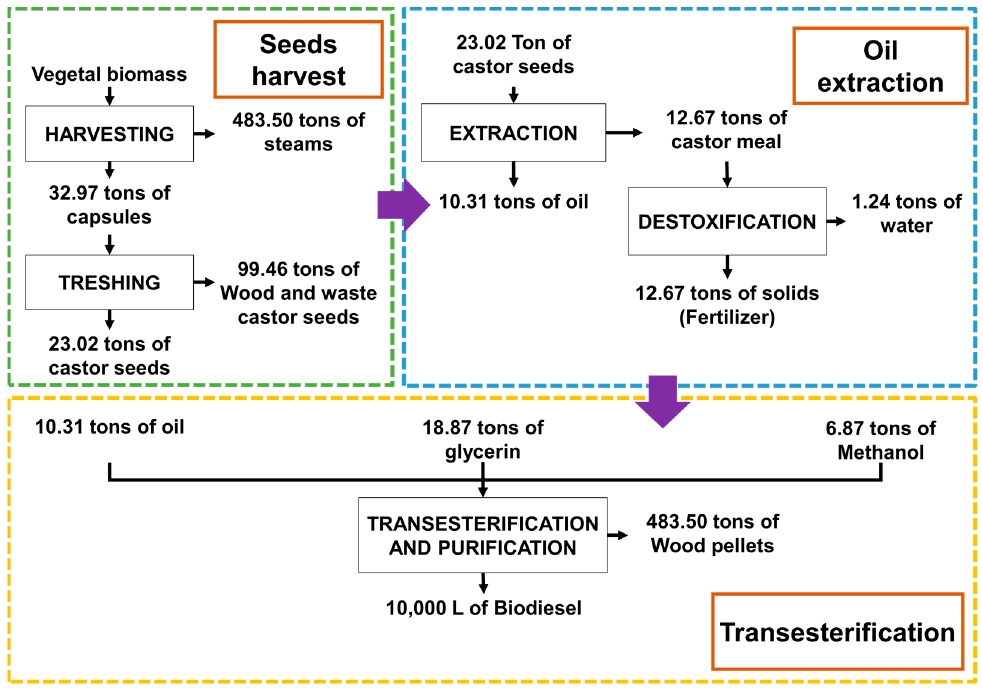
Figure 3. Balance of materials for castor bean co-product exploitation.